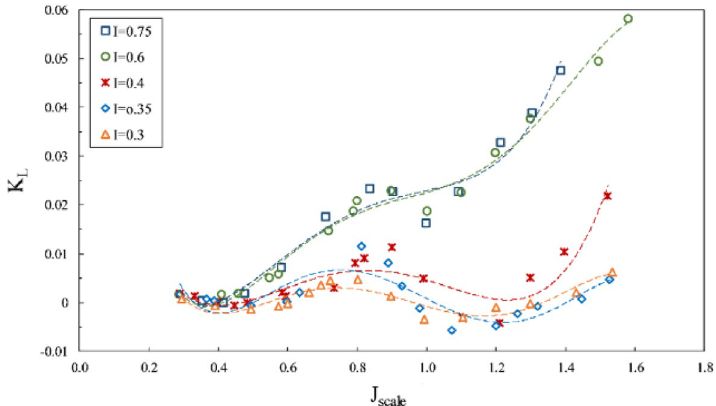
Figure 18. Effect of immersion ratio on the lift coefficient in the propeller direction ( α = 6 ◦ ).